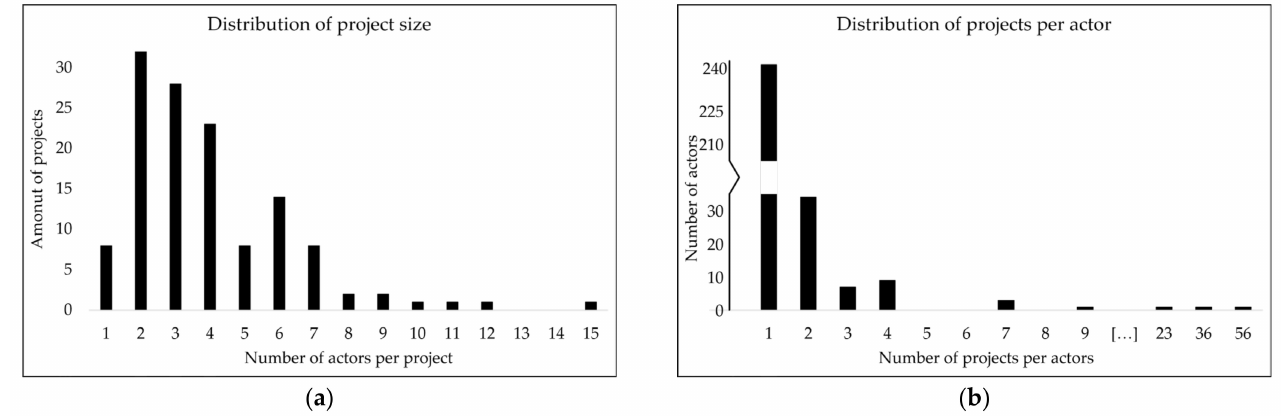
Figure 6. ( a ) Distribution of project size (i.e., number of actors per project); ( b ) Distribution of research projects per